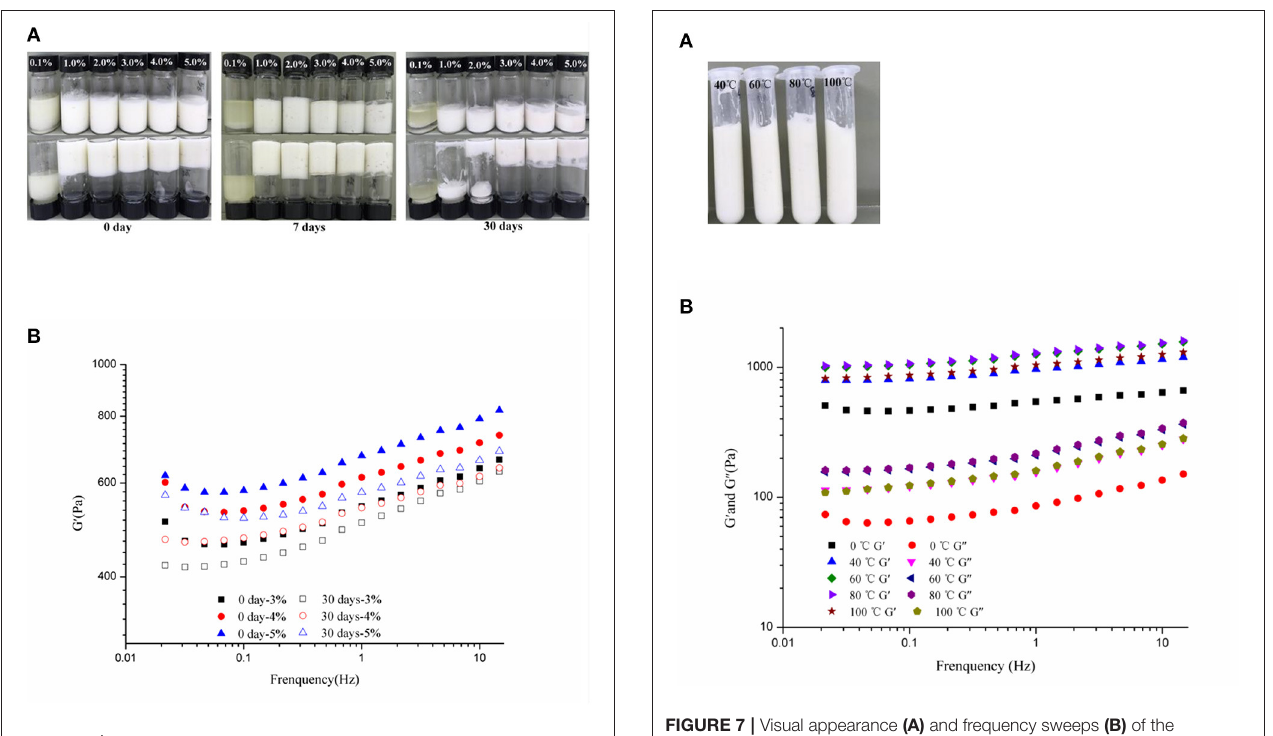
FIGURE 6 | Visual appearance (c: 0.1, 1, 2, 3, 4, and 5%) (A) and frequency sweeps (c: 3–5%) (B) of the WSP-stabilized HIPEs during storage at 0, 7, and 30 days, respectively.